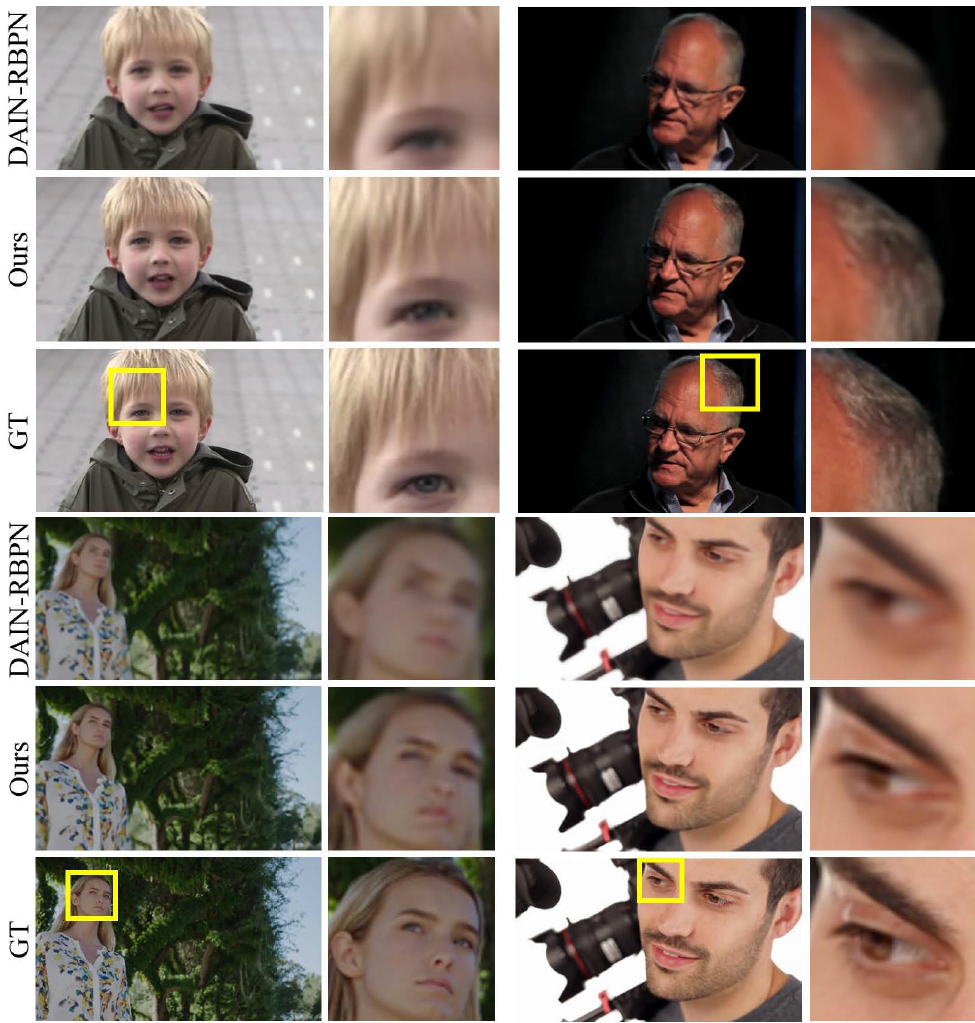
Figure 4. Comparison on the Vimeo90k dataset. Our method shows favorable human face recon- struction compared to DAIN-RBPN. The magnified regions are denoted as yellow